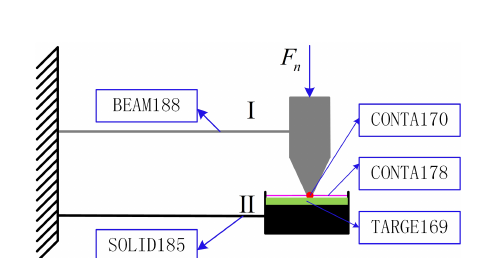
Figure 5. Typical thermal loading process.